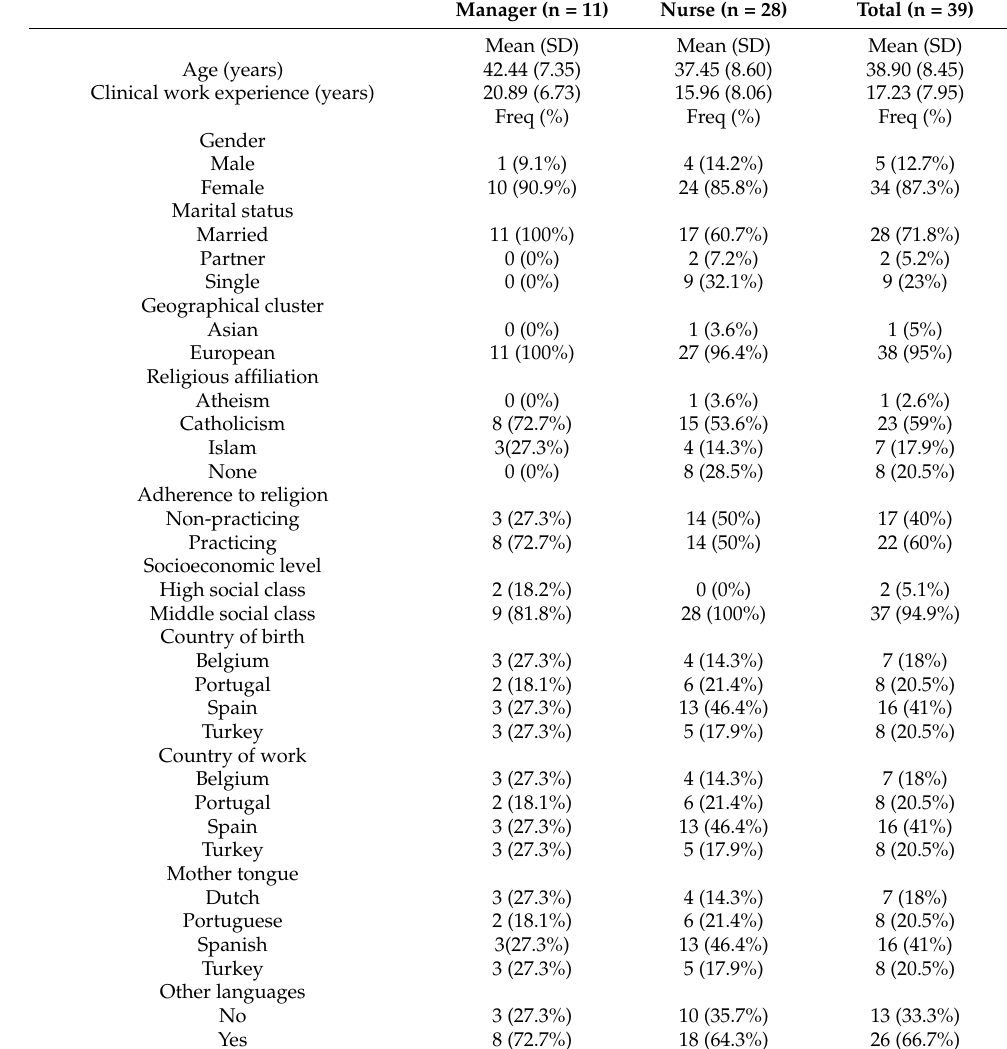
Table 4. Sociodemographic and cultural characteristics of the sample (n =